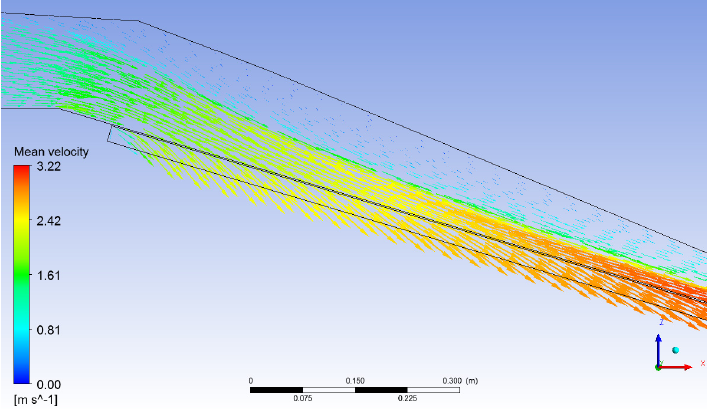
Figure 4. Velocity vectors calculated with numerical simulations for rack C ( m = 0.28), q 1 = 138.88 l/s/m and 30% slope.